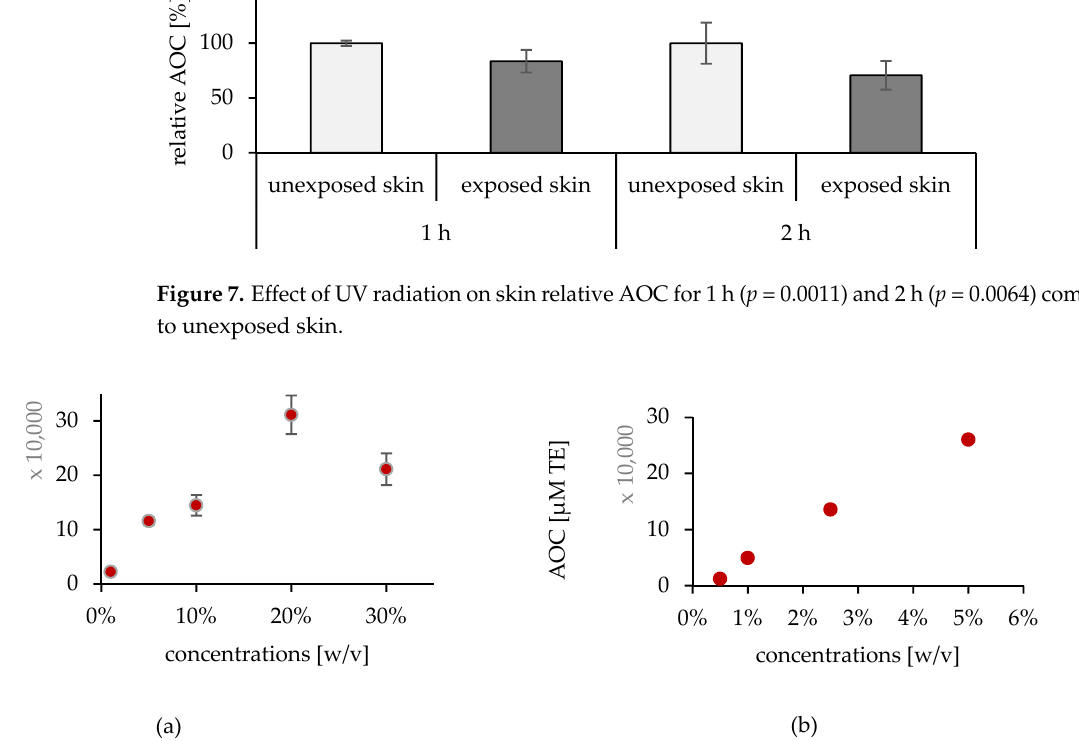
Figure 7. Effect of UV radiation on skin relative AOC for 1 h ( p = 0.0011) and 2 h ( p = 0.0064) com- pared to unexposed skin.